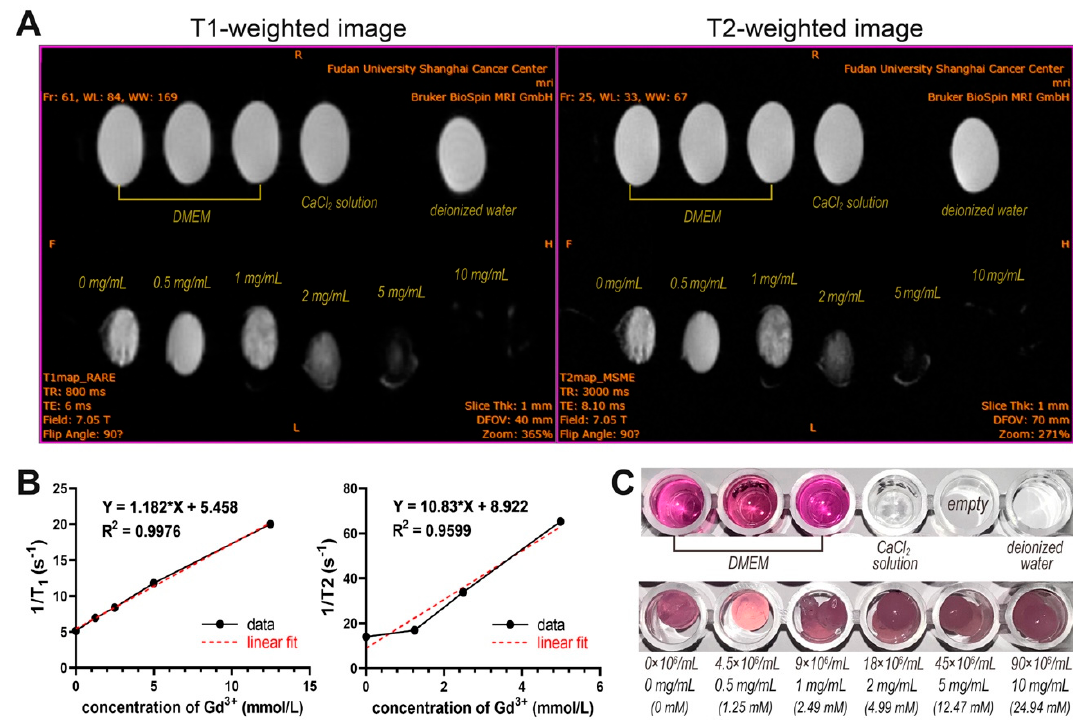
Figure 8. MRI of UCNP@SiO 2 -TS of increasing concentrations (0.5–10 mg/mL) and hydrogel constructs containing UCNP@SiO 2 -TS-labeled CSPCs of increasing numbers (4.5–90 × 10 6 cells/mL). ( A ) Representative T1-weighted (TR = 800 ms, TE = 6 ms) and T2-weighted (TR = 3000 ms, TE = 8.1 ms) MR phantom images of UCNP@SiO 2 -TS-labeled CSPCs of various concentrations. The signal intensity declines with Gd 3+ concentration, and the signals can hardly be measured when the nanoparticle concentrations are above 5 mg/mL (which corresponds to 4.99 mol/L of Gd 3+ concentration), which is inconsistent with the MRI capability of gadolinium. ( B ) According to the linear fitting curve, the longitudinal relaxivity (r1) is measured at 1.182 mM − 1 S − 1 , and the transverse relaxivity (r2) is measured at 10.83 mM − 1 S − 1 . ( C ) Gross view of the MRI phantoms.